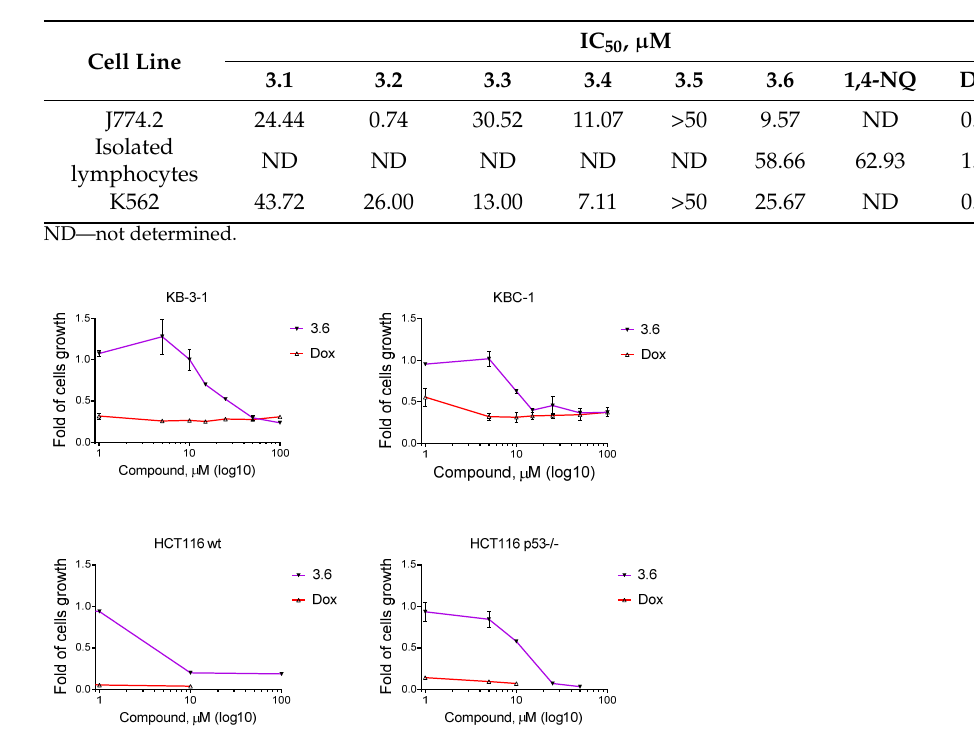
Figure 4. The viability curves of epidermoid (KB3-1, KBC-1) and colon (HCT116wt, HCT116 p53-/-) cells under derivative 3.6 and doxorubicin treatment. The anti-proliferative activity of studied compounds was analyzed by MTT assay after 72 h of cell exposure. Data presented as M ± SD, n = 3. Derivatives 3.1 , 3.2 , and 3.6 possessed an anti-proliferative effect on MCF-7 Table 2. Influence of Compounds and 1,4-NQ on the Growth of Individual Tumor Cell Lines.